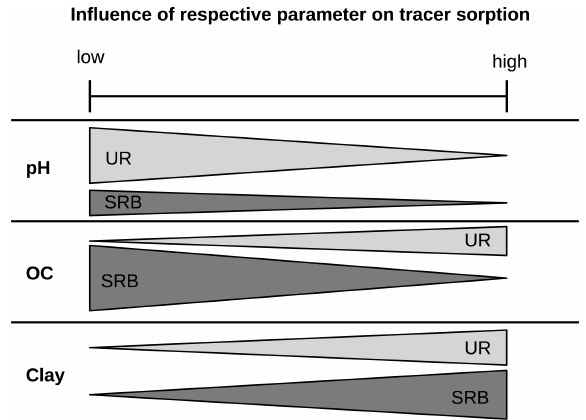
Figure 7. Schematic figure of the influence of the parameters OC, clay and pH on the adsorption of the fluorescent tracers UR and SRB. The width of the bars represents the measure of sorption and “low” and “high” refer to the soil